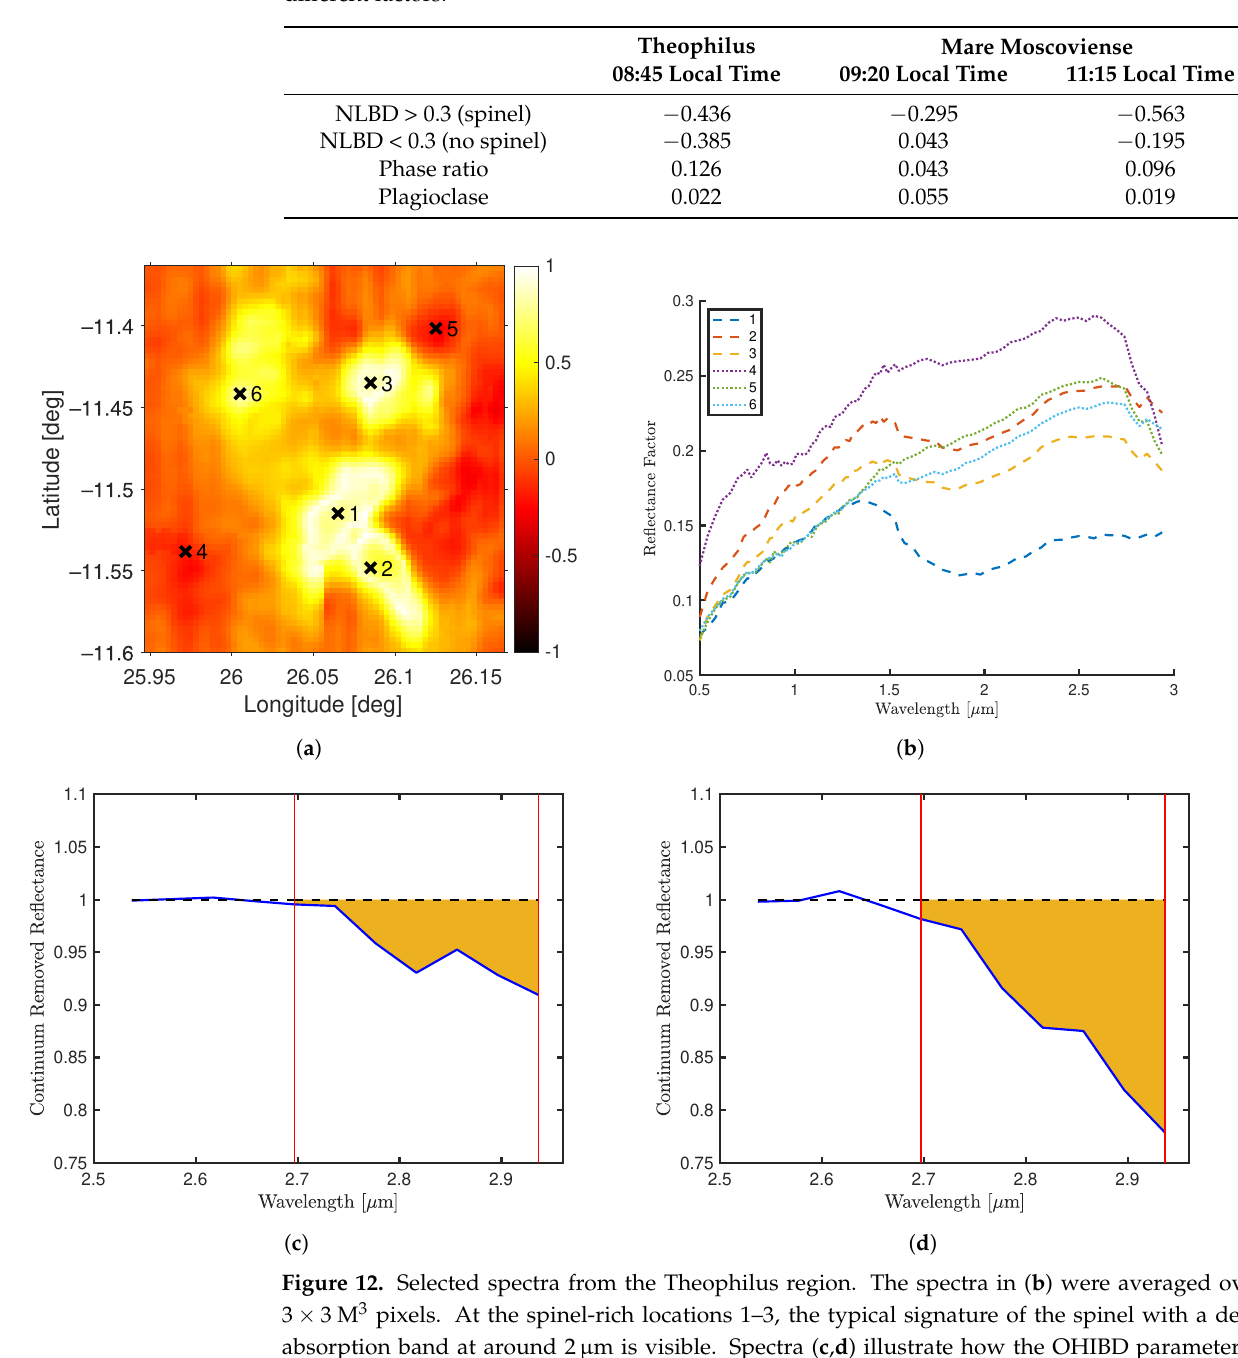
Figure 12. Selected spectra from the Theophilus region. The spectra in ( b ) were averaged over 3 × 3 M 3 pixels. At the spinel-rich locations 1–3, the typical signature of the spinel with a deep absorption band at around 2 µ m is visible. Spectra ( c , d ) illustrate how the OHIBD parameter is calculated at locations 2 and 5, respectively. After the continuum is fitted to the values between 2.537 and 2.657 µ m, the integral is determined, as shown in ( c , d ). ( a ) Position on the NLBD map, ( b ) Spectra, ( c ) Spectrum 2, ( d ) Spectrum